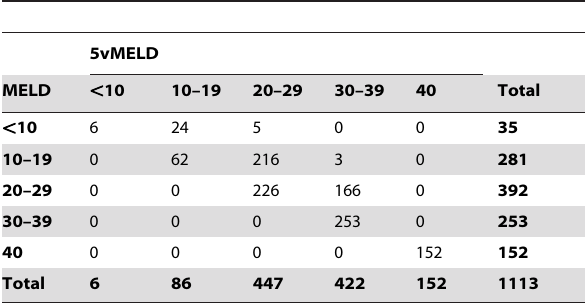
Table 4. MELD and 5vMELD Scores among 1,113 Patients from the Validation Cohort Who Died on the Waiting